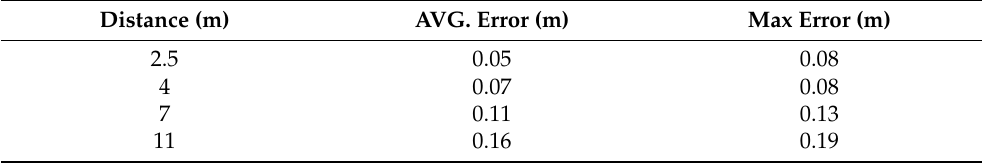
Table 2. Results of AEV’s distance estimation from the mobile station.